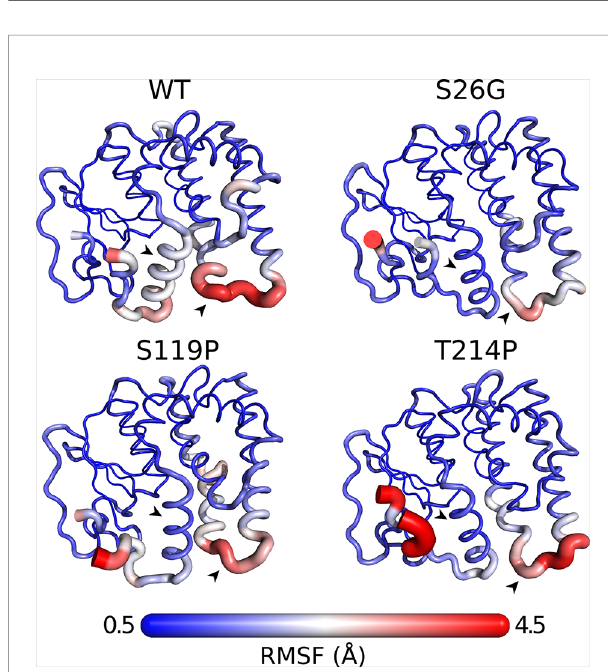
FIGURE 7 | Differences in conformational dynamics between GSTO-1 wild- type (WT), and the variants S26G, S119P, and T214P. The radius of the secondary protein structure and the gradient color (from 0.5 to 4.5 Å) are functions of the RMSF values calculated. As the most affected protein regions, arrowheads highlight the helix a 10 (black) and the loop between helixes a 6 and a 7 (white),